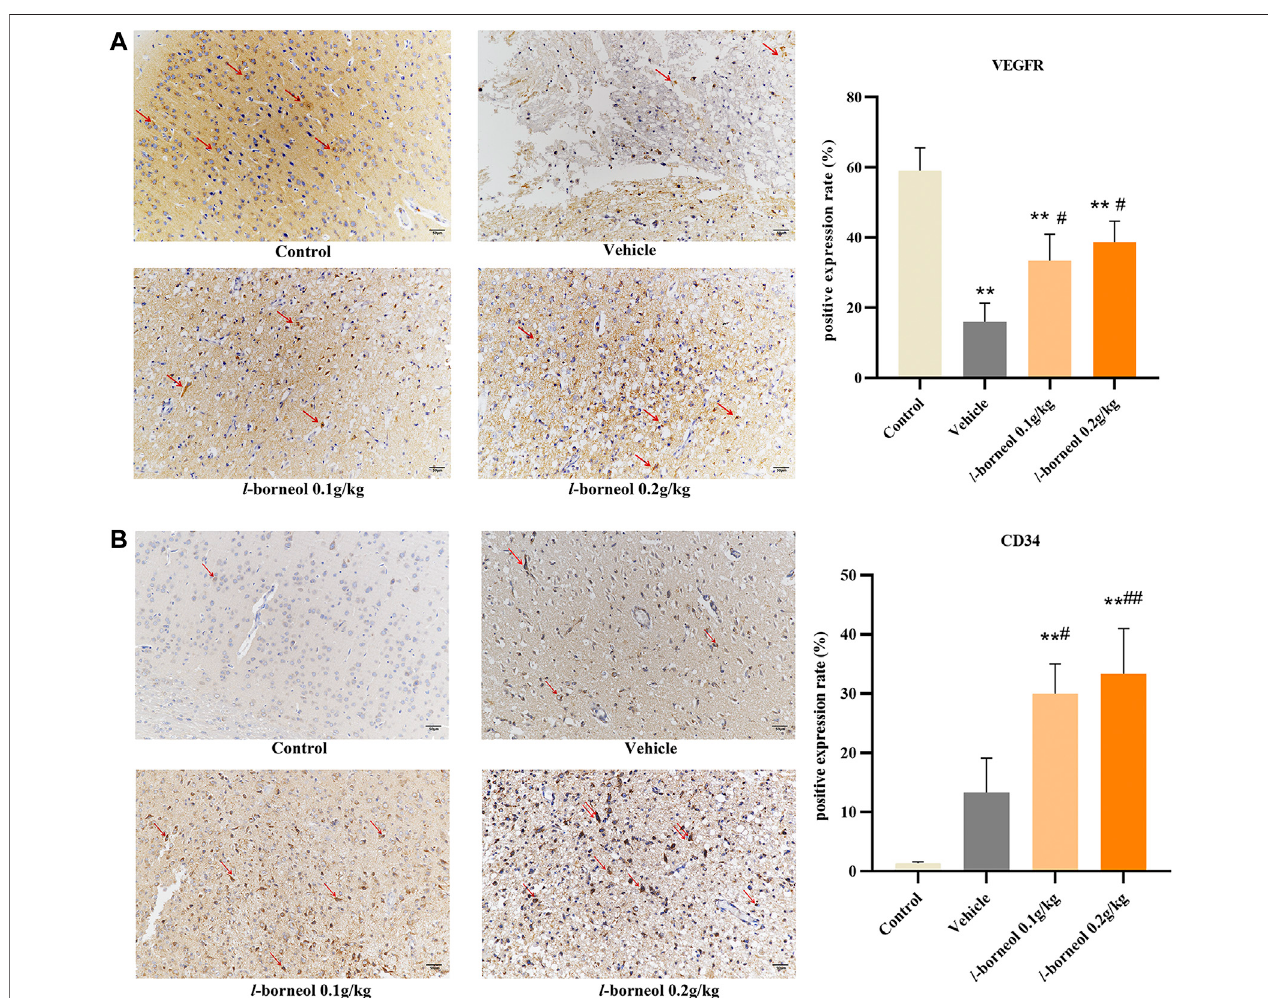
FIGURE 9 | Illustration of VEGFR and CD34 expression using IHC staining ( n (cid:2) 3). ** p < 0.01, compared with the control group; # p < 0.05, ## p < 0.01, compared with the vehicle group, red arrow indicates positive expression.